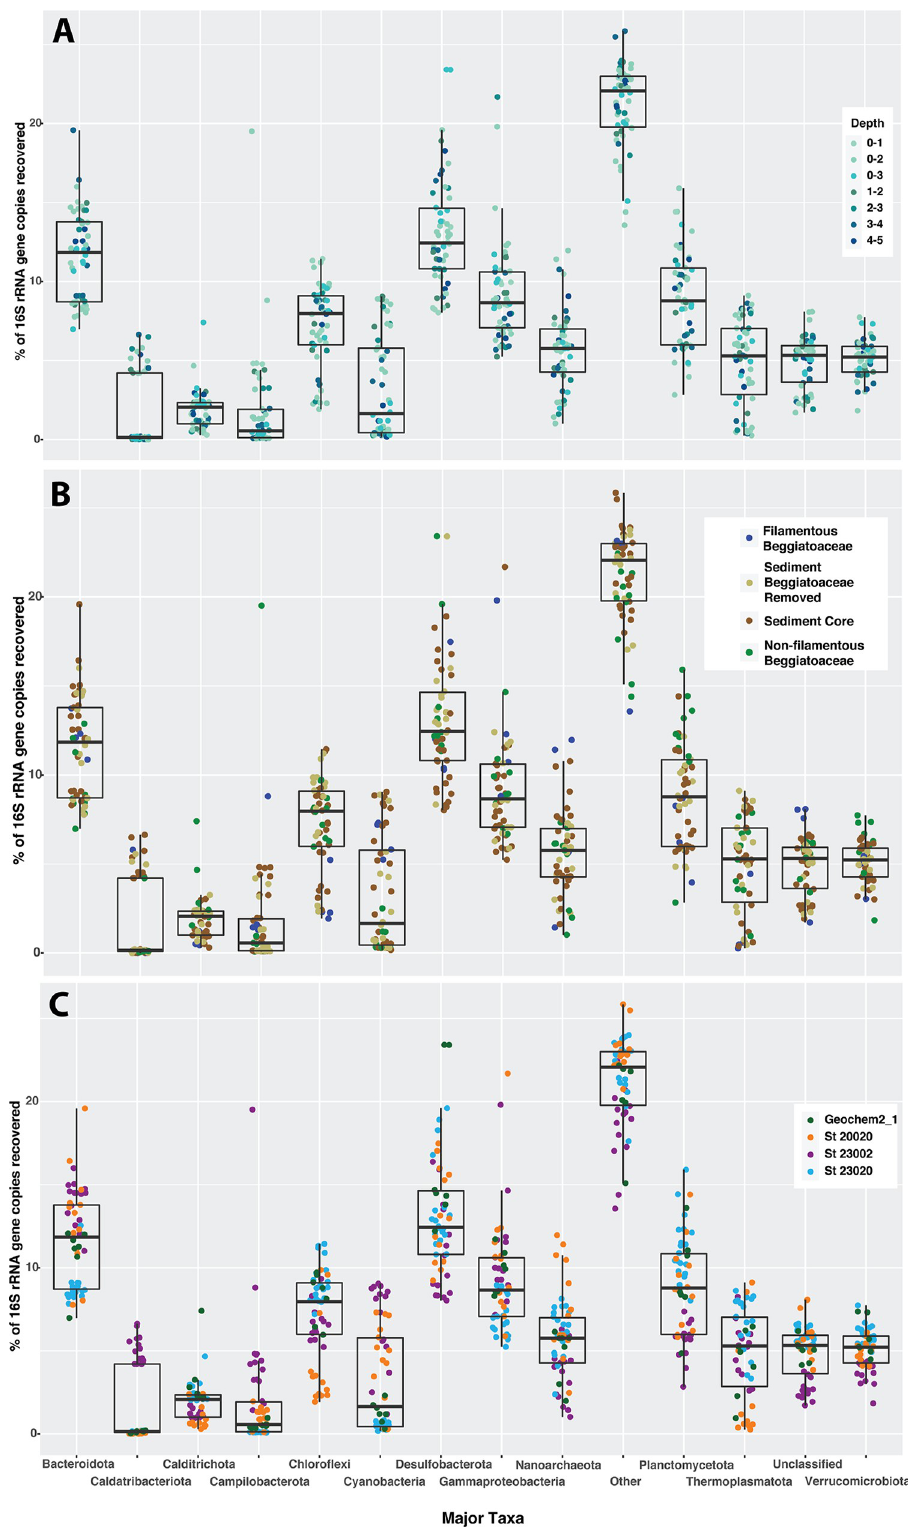
Fig 5. Box plots of the phyla of ASVs by percent community composition by A. depth in cm. B. sample type. C. location.